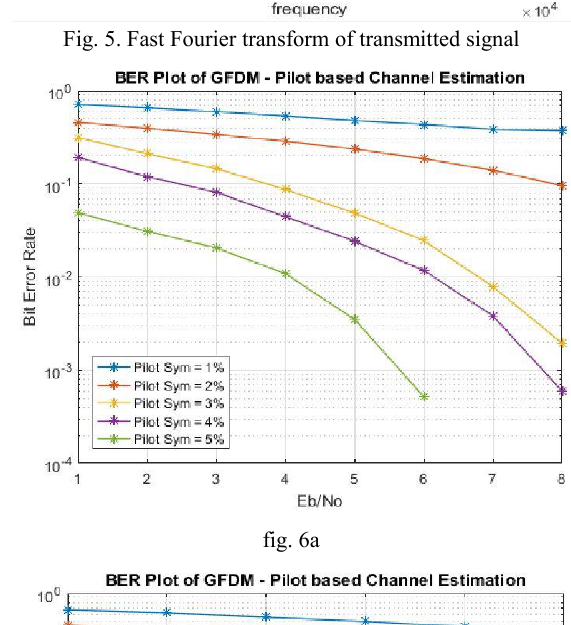
Fig. 5. Fast Fourier transform of transmitted signal